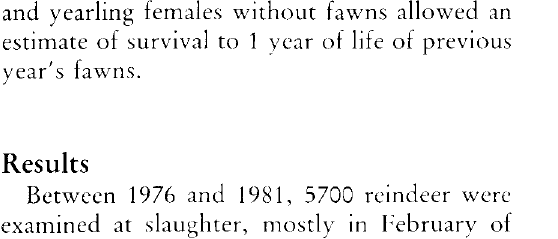
Table 1. Annual reprod' uctive rates of female rein- deer o btained at slaughter